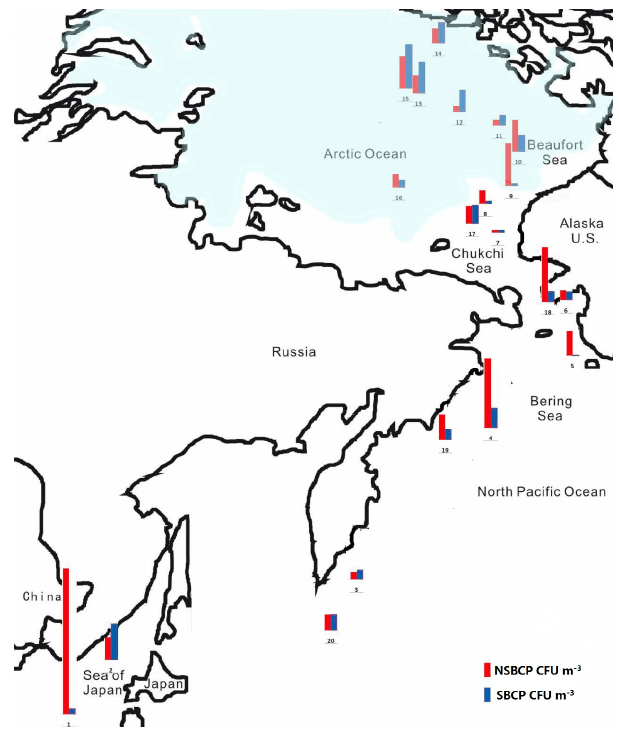
Figure 1. Bacterial concentrations along the cruise path for the R/V Xuelong during the third China Arctic Research Expedition. The concentrations of airborne non-salt tolerant bacteria-containing particles (NSBCPs) and airborne salt tolerant bacteria-containing particles (SBCPs) are shown by red and blue columns, respectively (unit: CFU m − 3 ). The blue shaded area represents sea ice.